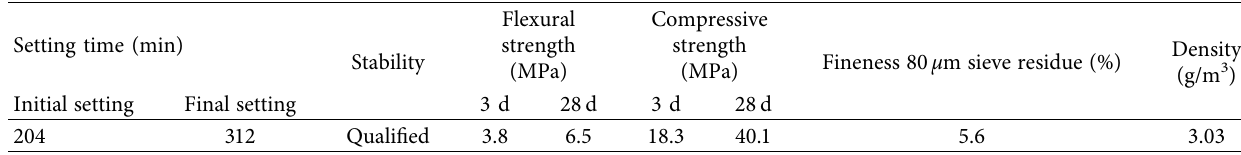
Table 3: Physical properties of the cement.